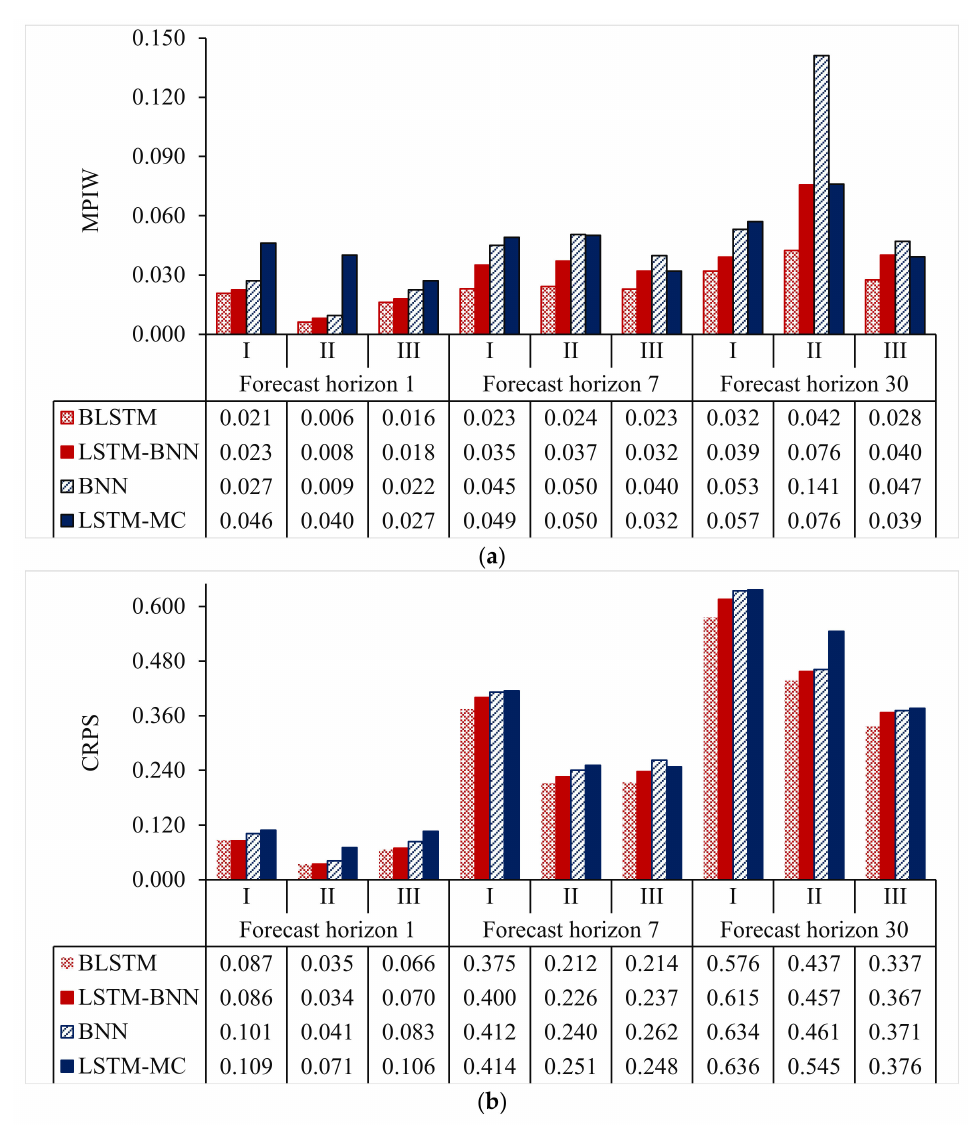
Figure 6. Comparison among prediction models in terms of ( a ) MPIW and ( b )